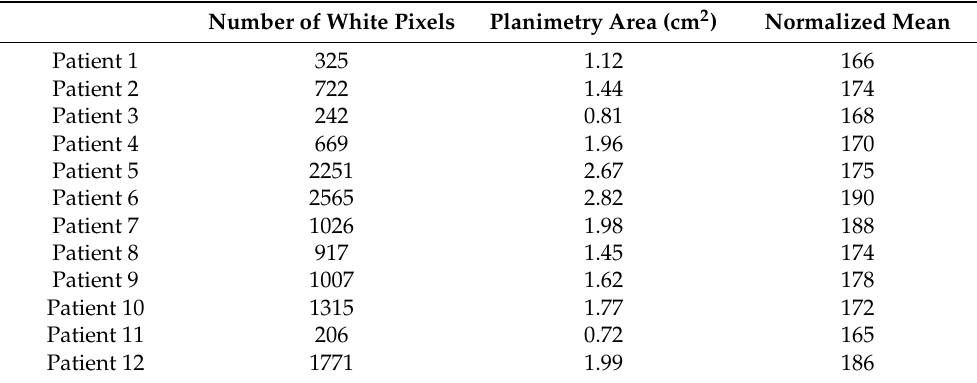
Table 2. Validation Study in a controlled patient representative—the number of white pixels (showing calcium) versus planimetry area measured manually. Number of White Pixels Planimetry Area (cm 2